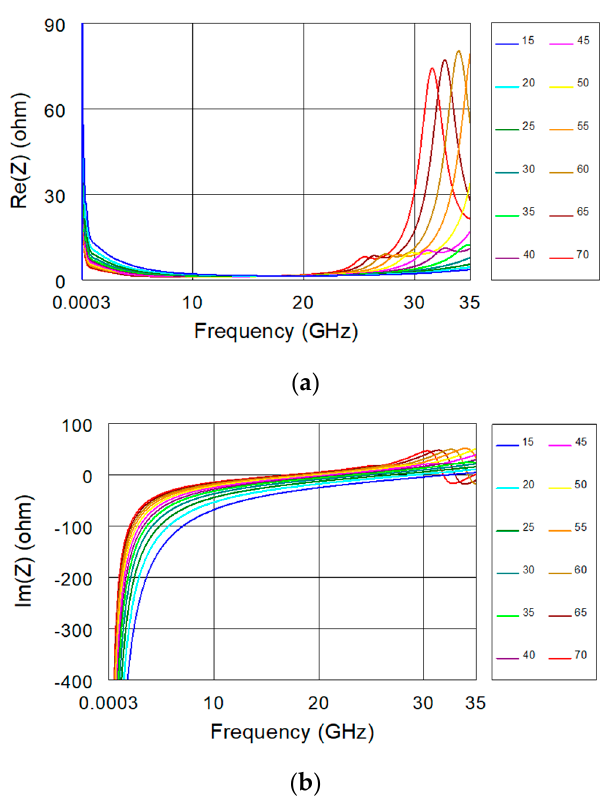
Figure 9. FEM simulations of the ( a ) real and ( b ) imaginary parts of the impedance from 0.3 MHz to 35 GHz for the IDC sensor loaded with lossless MUTs having a real part of the relative permittivity varied from 15 to 70 with a step of 5.